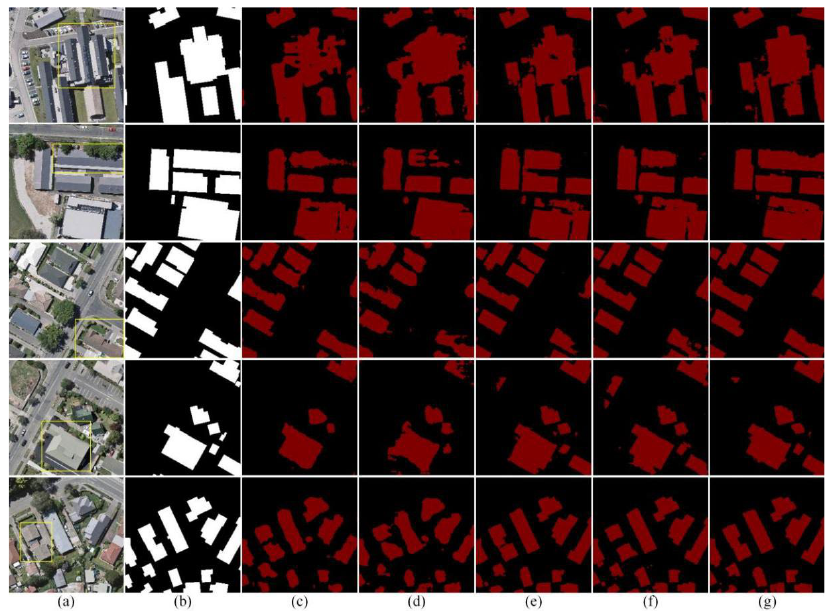
Figure 6. Typical building extraction results on the WBD. ( a ) Images. ( b ) Labels. ( c ) DeepLabv2. ( d ) PSPNet. ( e ) UNet. ( f ) TransUNet. ( g ) TRANet. Yellow boxes identify partial differences between the different methods.